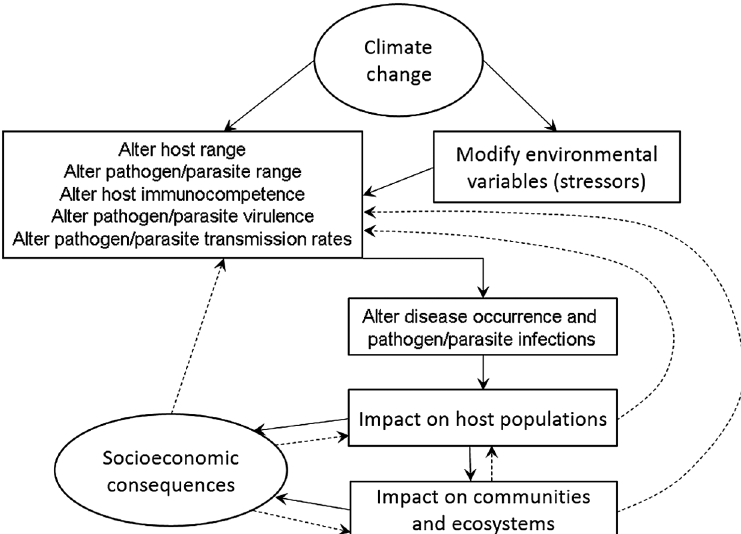
Fig. 1. Schematic representation of climate change effects on pathogens/ parasites and their hosts. Effects will cascade, impacting host populations, communities, and ecosystems (solid lines). Effects will be further modified by interactions with other stressors and environmental variables. Population and community effects will feed back to hosts, their pathogens, and parasites (dashed lines). Modified from Marcogliese